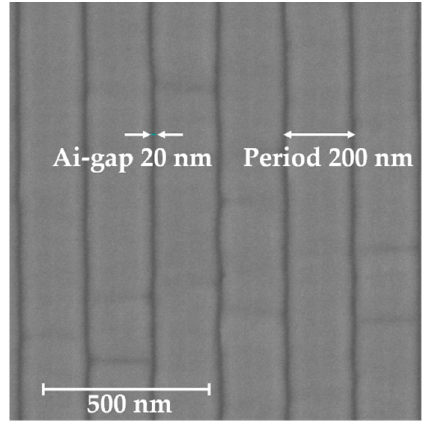
Figure 3. Scanning electron microscope (SEM) image of the GaN-HCG.